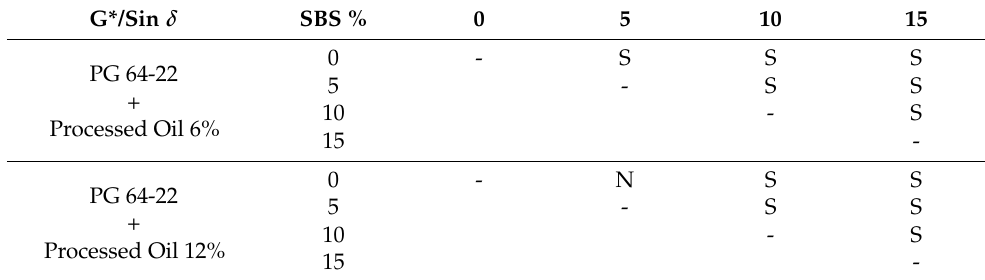
Table 9. Statistical analysis results of G*/sin δ for RTFO aged PG 64-22 with processed oil as a function of SBS content ( α = 0.05).